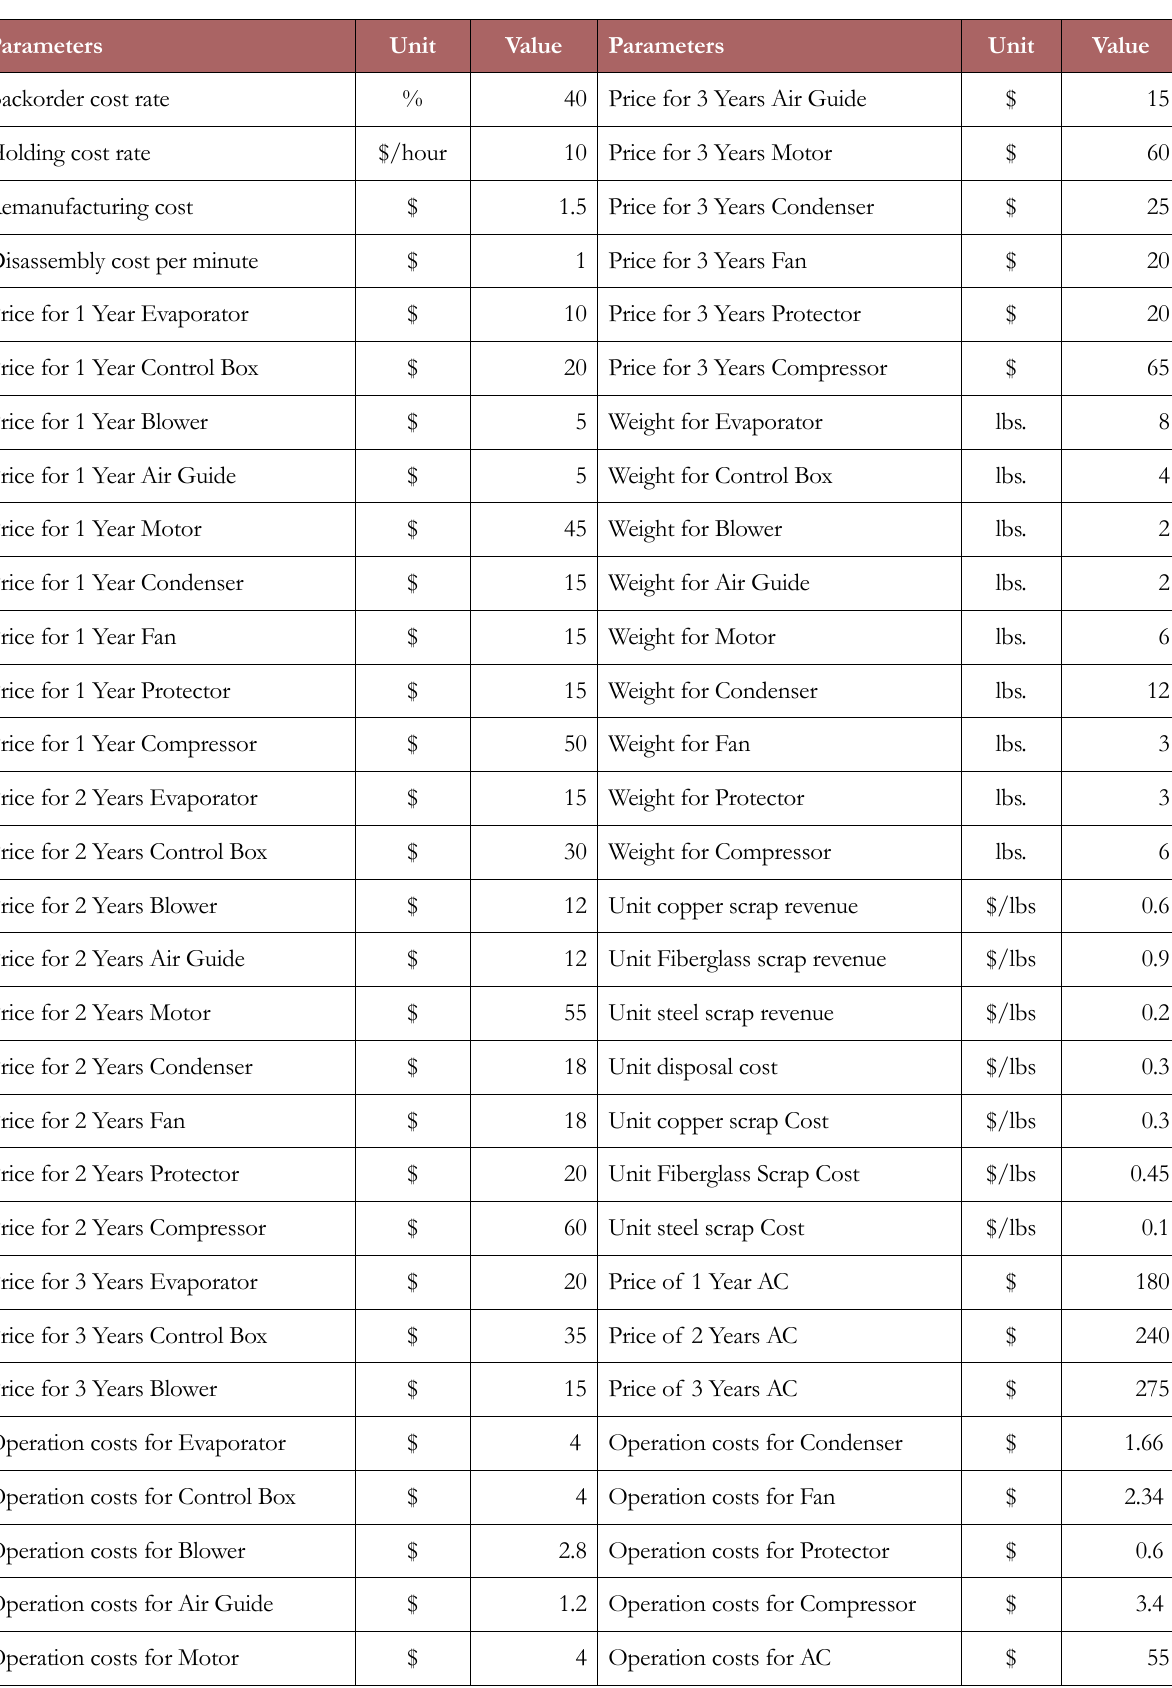
Table 2. Parameters used in the ARTO